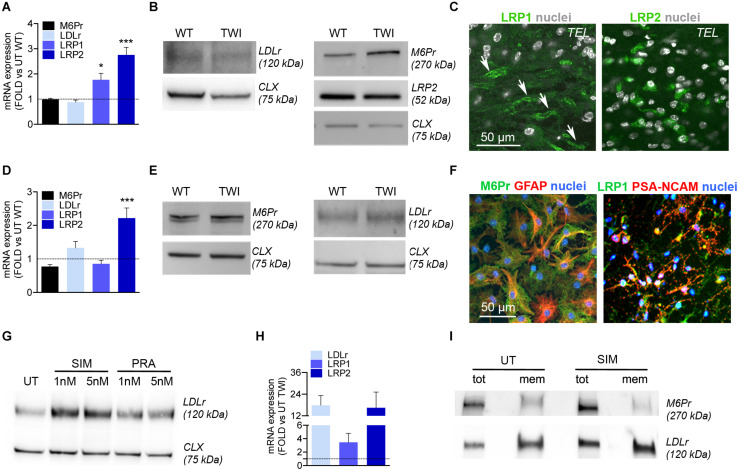
NPCs and progeny express LDLr and LDLr-related proteins. (A) Relative mRNA expression of LDLr, LRP1, LRP2, and M6Pr in the telencephalon (TEL) of TWI mice at postnatal day (PND) 40. Data are expressed as fold to WT (dotted line). Data represent the mean ± SEM; n = 3 animals/group. ΔΔCT values were analyzed by One Way Anova followed by Dunnet’s multiple comparison test; *p<0.05, ***p<0.001 vs. UT WT. (B) Representative WB showing LDLr, LRP2, and M6Pr protein in the TEL of TWI and WT mice at PND 40. Calnexin (CLX) was used as normalizer. (C) Representative confocal IF pictures showing LRP1 and LRP2 expression in TEL of symptomatic TWI mice at PND 40. Arrows indicate endothelial cells. Nuclei counterstained with Hoechst (gray, pseudocolor). 40× magnification. Scale bar, 50 μm. (D) Relative mRNA expression of LDLr, LRP1, LRP2, and M6Pr in TWI NPC-derived neuronal/glial cell cultures. Data are expressed as fold to WT (dotted line). Data represent the mean ± SEM; n = 3 independent experiments. ΔΔCT values were analyzed by One Way Anova followed by Dunnet’s multiple comparison test, ***p< 0.001 vs. UT WT. (E) Representative WB showing M6Pr and LDLr protein in TWI and WT NPC-derived neuronal/glial cell cultures. Calnexin (CLX) was used as normalizer. (F) Representative confocal IF merged pictures showing M6Pr (green) and LRP1 (green) expression in TWI NPCs-derived astrocytes (GFAP, red) and neuronal progenitors (PSA-NCAM, red). Nuclei counterstained with Hoechst (blue). 40× magnification. Scale bar, 50 μm. (G) Representative WB showing LDLr protein in the total lysate of WT NPCs, either UT or treated for 24 h with 5 and 1 nM of Simvastatin (SIM) and Pravastatin (PRA). Calnexin (CLX) was used as normalizer. (H) Relative mRNA expression of LDLr, LRP1, and LRP2 in SIM-treated TWI NPCs. Data are expressed as fold to UT TWI (dotted line). Data represent the mean ± SEM; n = 2 independent experiments in duplicate. (I) Representative WB showing LDLr and M6Pr protein in the total lysate (tot) or membrane (mem) fraction isolated from TWI NPCs, either UT or treated for 24 h with 1 nM of Simvastatin (SIM).